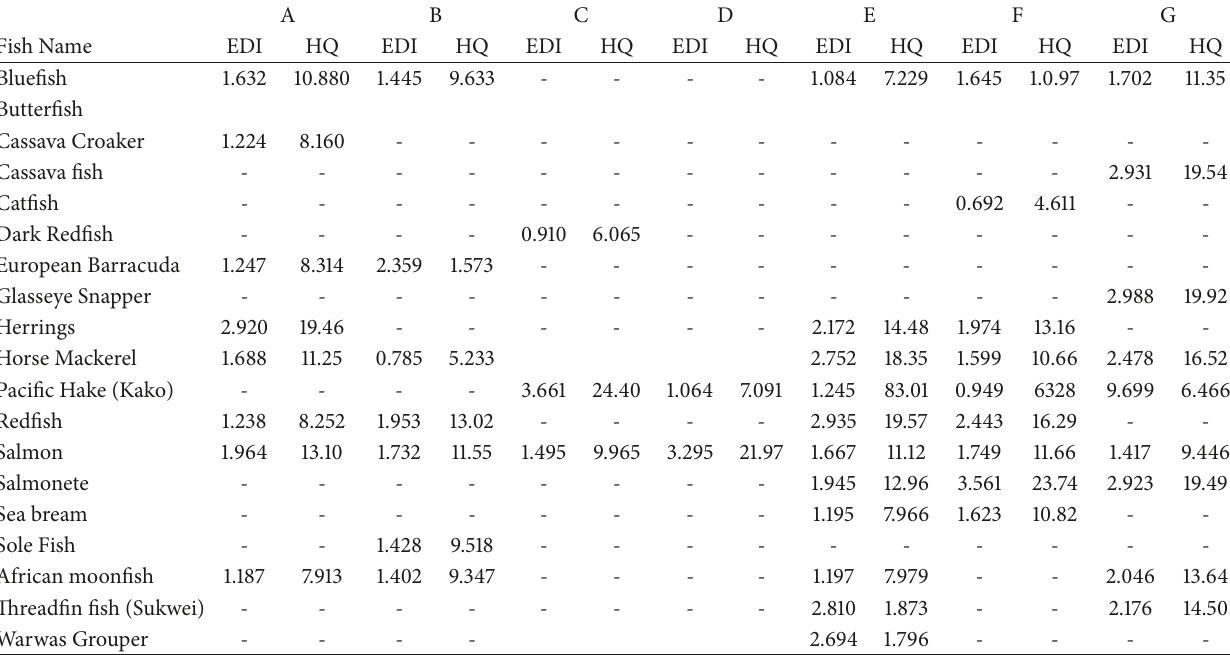
Table 5: The EDI results for carcinogenic risk evaluation expressed in mg/kg body weight/day. A B C